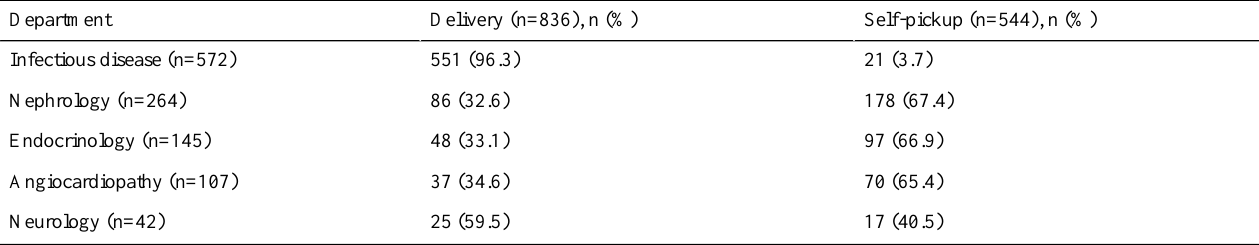
Table 2. Delivery/self-pickup preference of online prescription patients